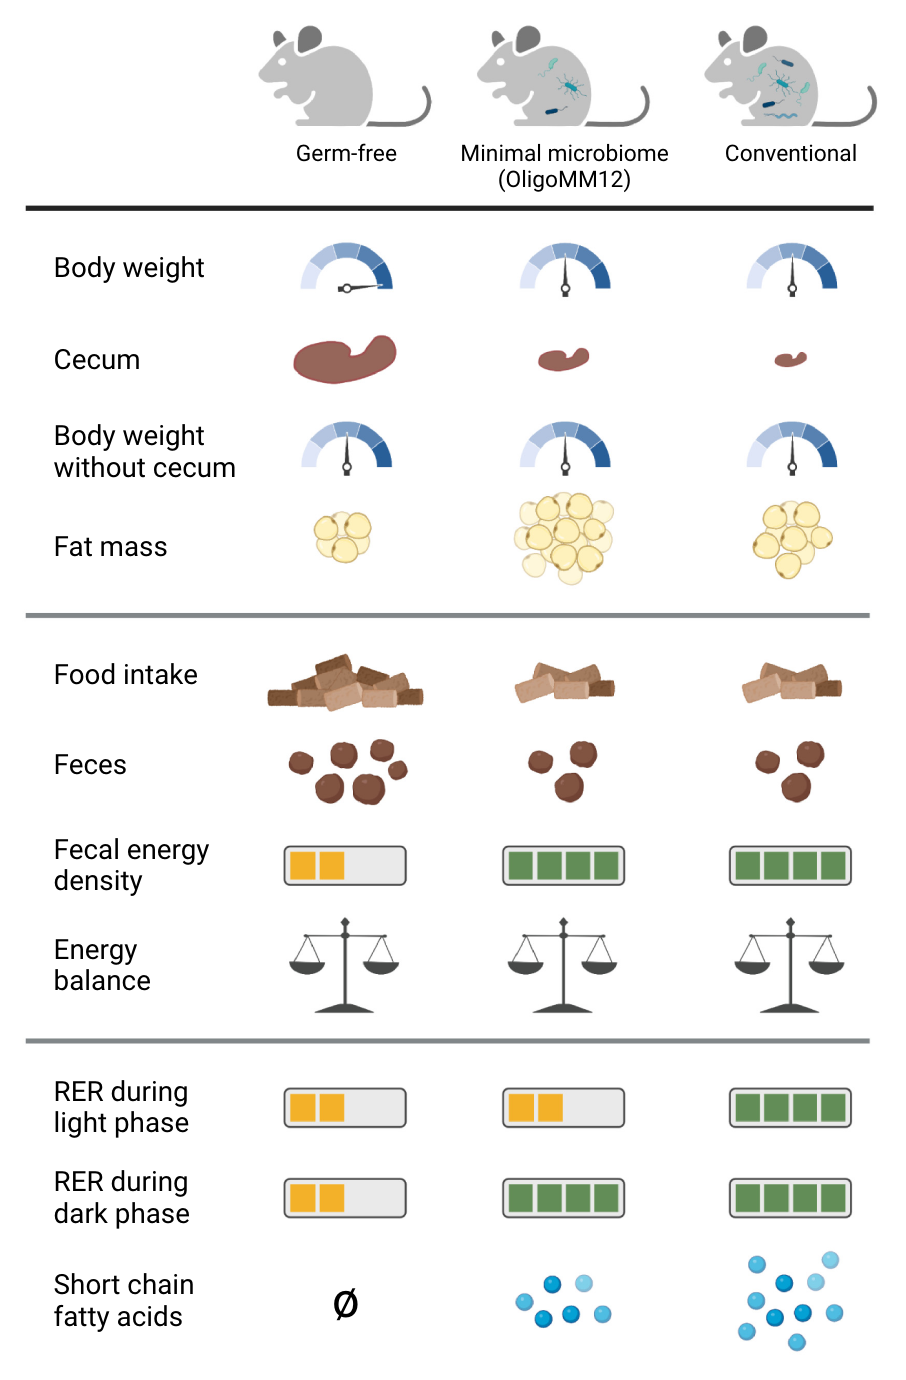
ø Fig 1. Summary of key metabolic parameters in mice harboring microbiomes of different complexity. (Top) GF mice are heavier than OligoMM12 mice and conventional mice, but after subtracting the weight of the cecum, all 3 groups have approximately the same weight. OligoMM12 have greater fat mass than the other 2 groups. (Middle) GF mice have greater food intake, increased fecal output, and lower fecal energy density than the other 2 groups. The result is that GF mice extract as much total energy from food as the other 2 groups. All 3 groups also have approximately equal energy expenditure, leading to neutral energy balance. (Bottom) During the light phase, GF and OligoMM12 mice have lower RER than conventional mice, but during the dark phase, OligoMM12 and